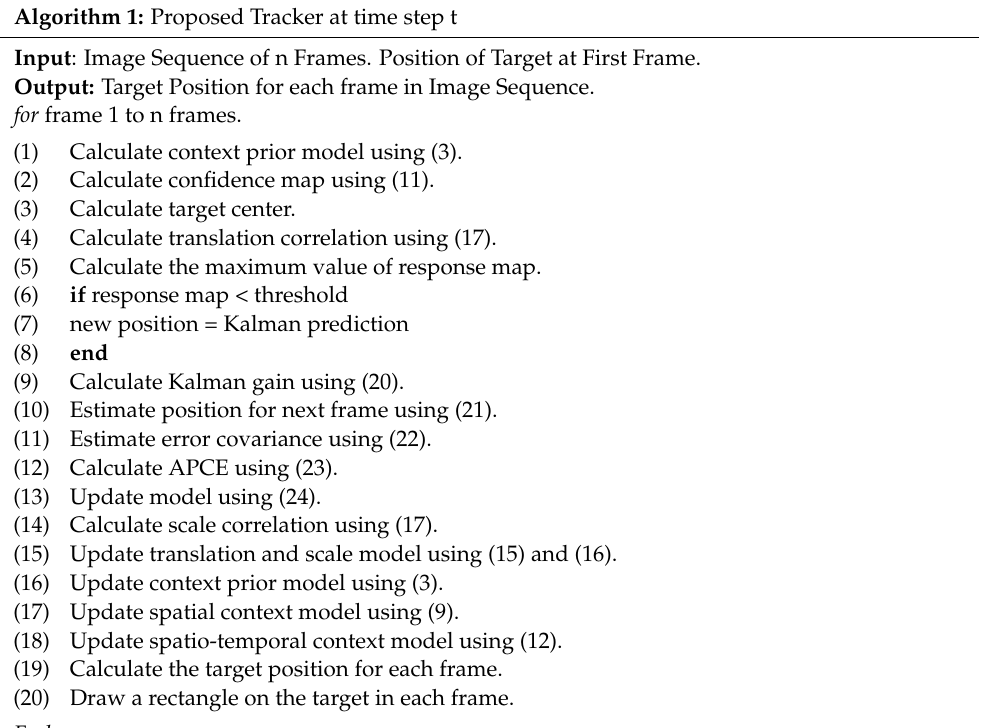
Algorithm 1: Proposed Tracker at time step